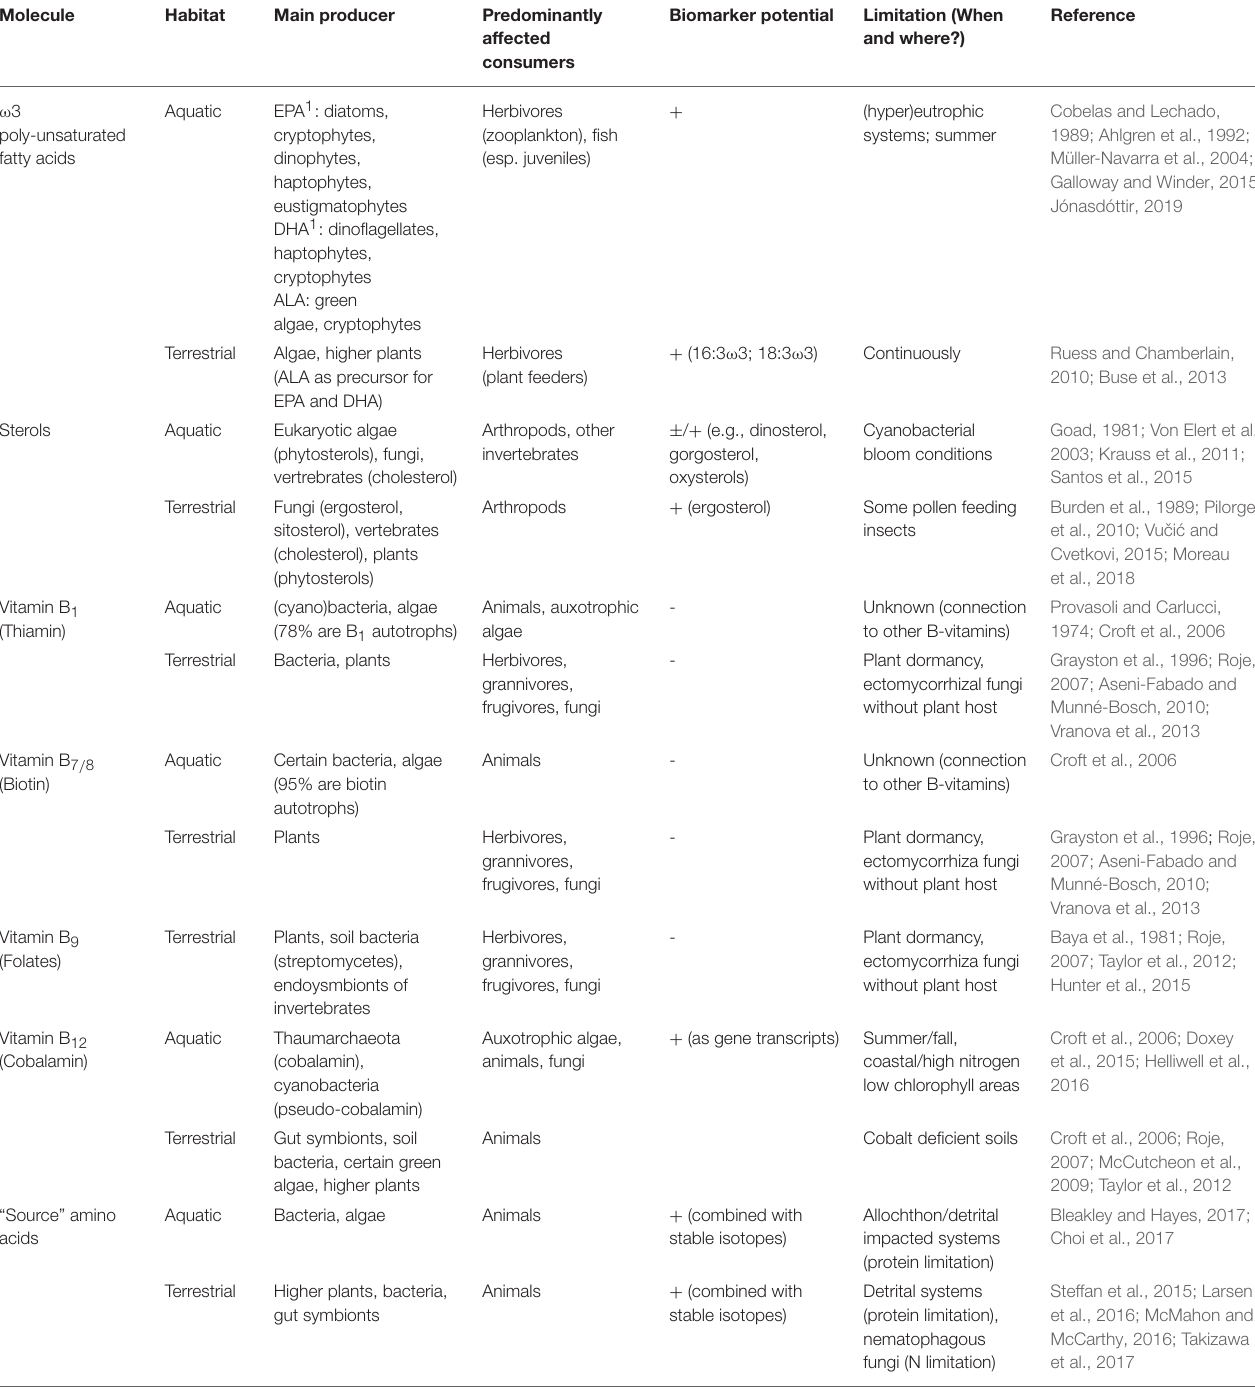
TABLE 1 | Essential biomolecules within the groups of fatty acids, sterols, vitamins, and amino acids. Molecule